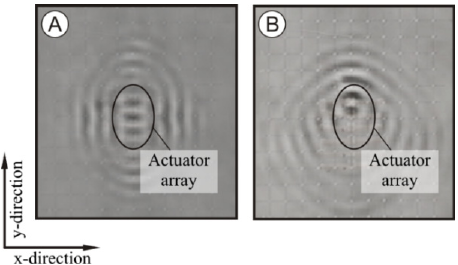
Figure 14. Out ‐ of ‐ plane velocities at t = 20 µs for different time delays. ( A ) for zero seconds; ( B ) for 24 ms. Figure 14. Out-of-plane velocities at t = 20 µ s for different time delays. ( A ) for zero seconds; ( B ) for 24